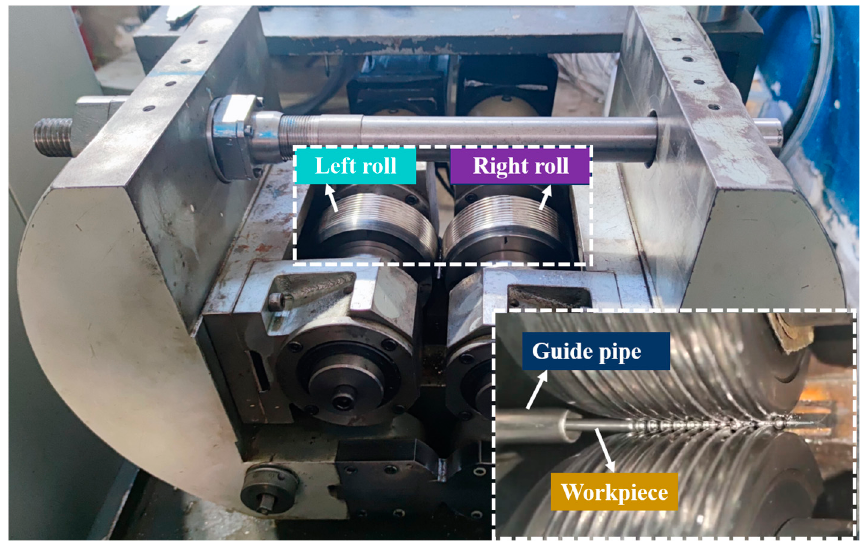
Figure 2. Experimental skew rolling mill and workpiece.